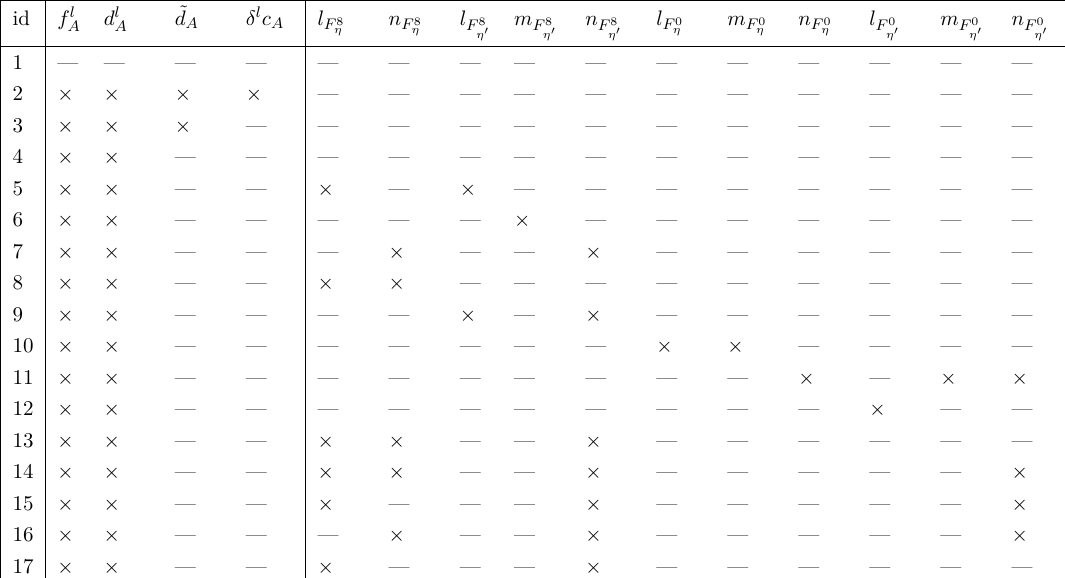
Table 7. Fit forms employed to estimate the systematic uncertainty associated with performing the continuum limit extrapolation. A cross indicates the corresponding term is included in the fit form (see section 5.4) and the coefficient is reasonably well determined. f A , d A , ˜ d A and δc A are the unknown O improvement coefficients and the coefficients of O ( a 2 ) corrections l O , m O and n O are defined in eq. (5.53). The values of these coefficients can be found in appendix D. In all the cases, the NLO large- N c expressions are used for the continuum part of the fit